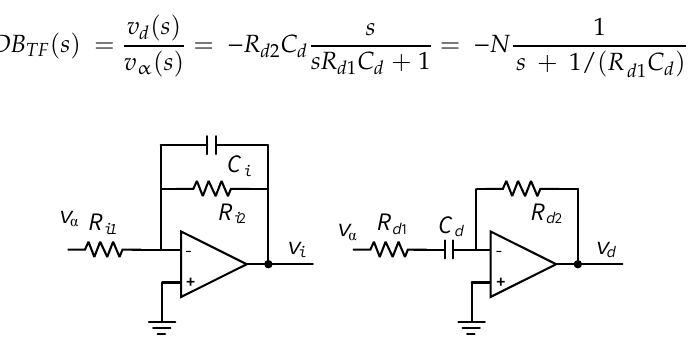
Figure 10. Integrator and differentiator for analog implementation.